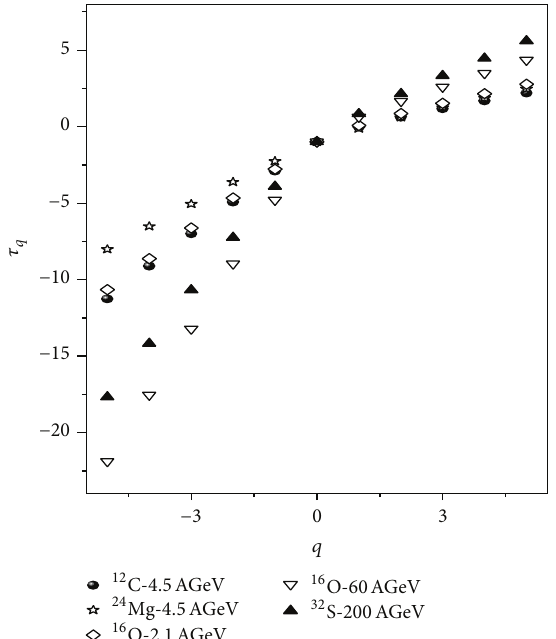
Figure 5: Comparison of 𝜏 𝑞 spectra for experimental and shuffled data for 32 S-AgBr interactions at 200